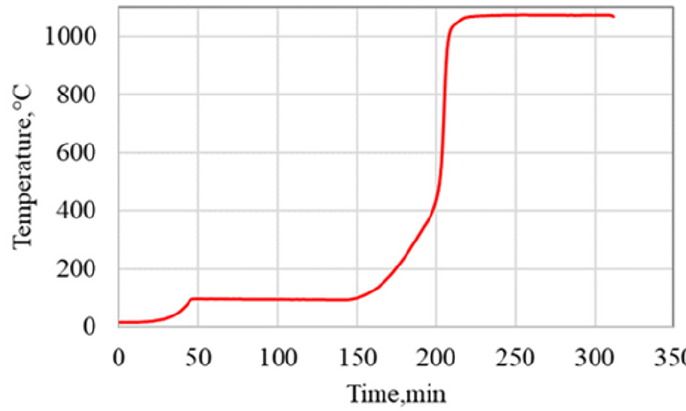
Figure 2. Typical temperature profile during carbonization in the Tamman furnace.